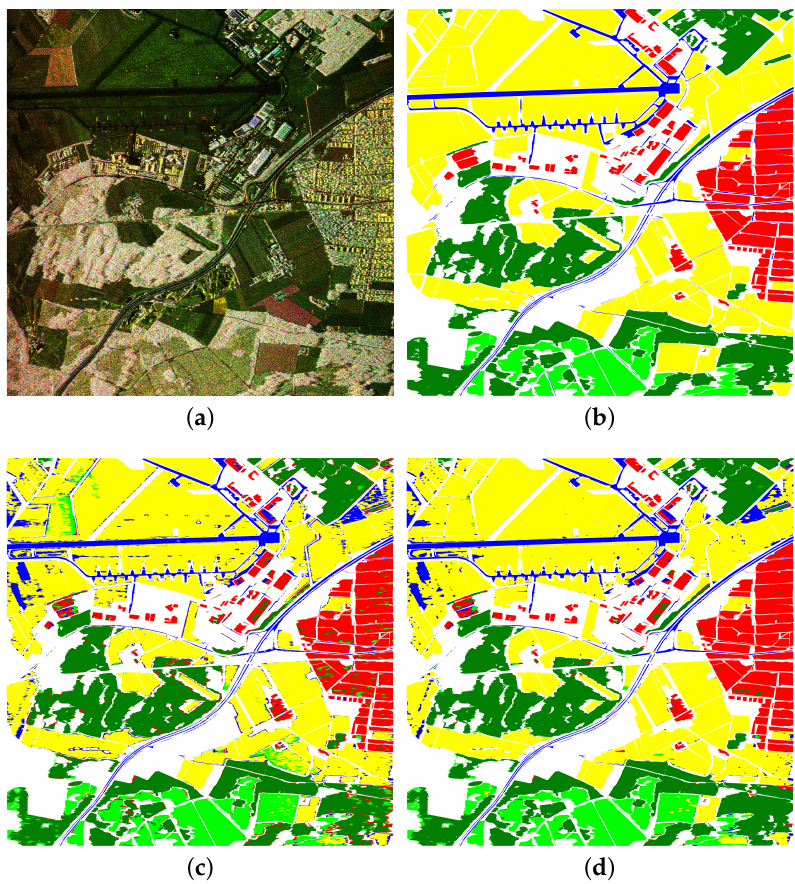
Figure 3. Input data and results of the Oberpfaffenhofen dataset. ( a ) Image Data (E-SAR, DLR, L-Band); ( b ) Reference Data: City (red), Road (blue), Forest (dark green), Shrubland (light green), Field (yellow), unlabelled pixels in white; ( c ) Classification map obtained by the RF at Level 0; ( d ) Classification map obtained by the RF at Level